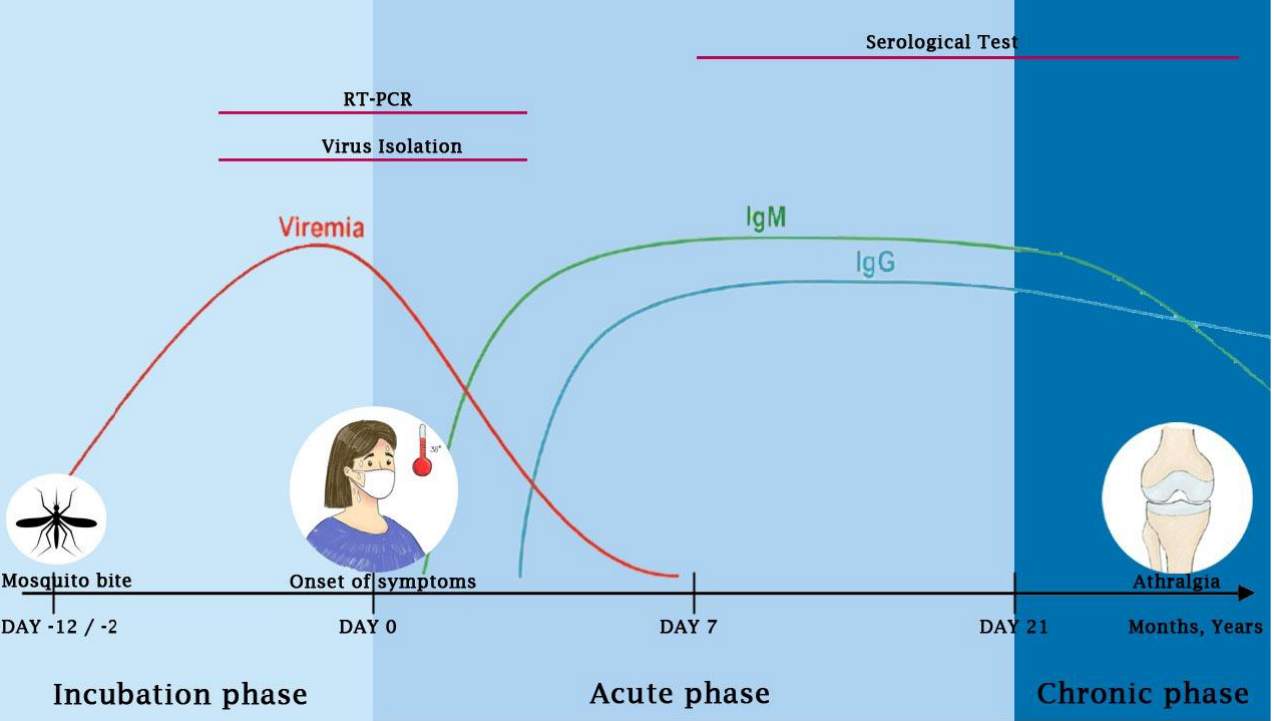
Figure 4. The course of CHIKV infection and its association with different approaches to diag- nose CHIKV infection. The RT-PCR and virus isolation are best performed near the onset of febrile illness where viremia reaches its highest level. The serological tests to detect the presence of IgM and IgG are best performed after seven days of the symptom onset.